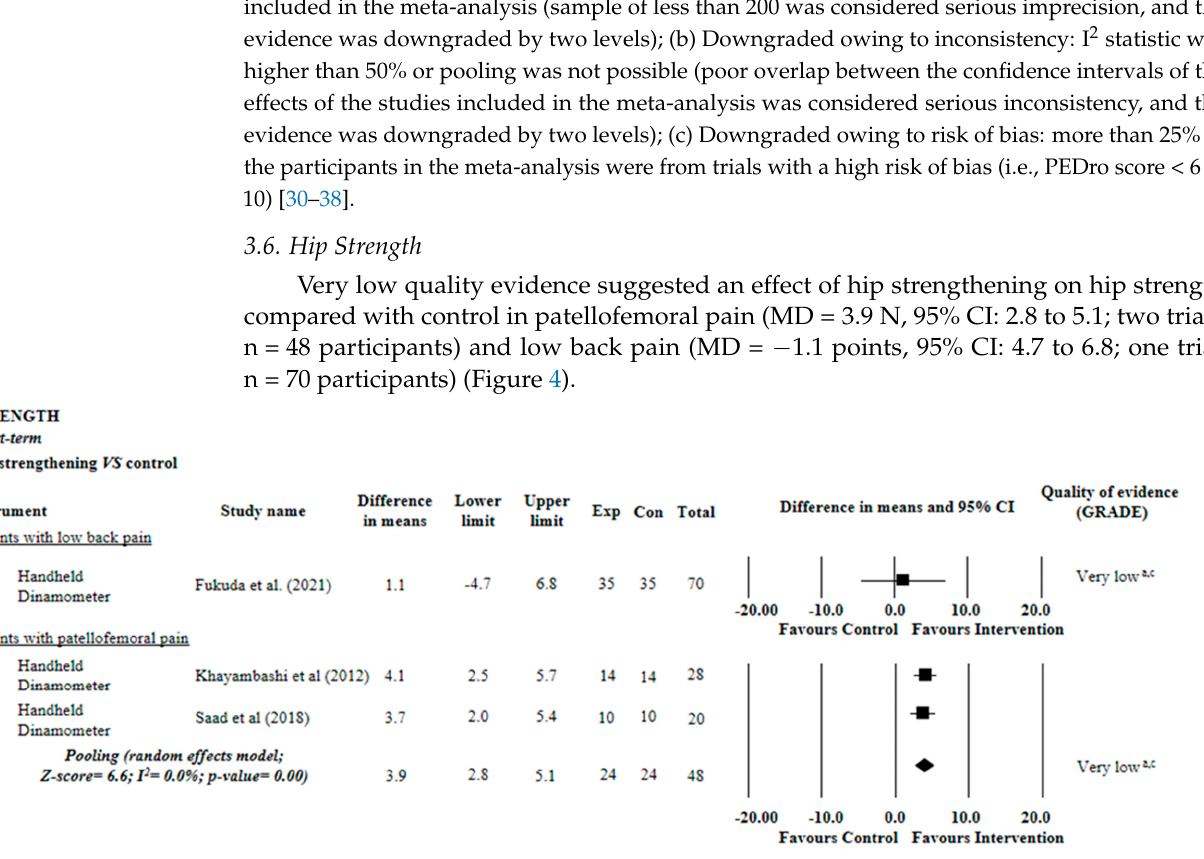
Figure 4. Summary of evidence of the effect of hip strengthening on strength. Control: sham, placebo, no intervention, or waiting list. (a) Downgraded owing to imprecision: less than 400 participants included in the meta-analysis (sample of less than 200 was considered serious imprecision, and the evidence was down-graded by two levels); (b) Downgraded owing to inconsistency: I 2 statistic was higher than 50% or pooling was not possible (poor overlap between the confidence intervals of the effects of the studies included in the meta-analysis was considered serious inconsistency, and the evidence was downgraded in two levels); (c) Downgraded owing to risk of bias: more than 25% of the participants in the meta-analysis were from trials with a high risk of bias (i.e., PEDro score < 6 of 10) [31,32,37].